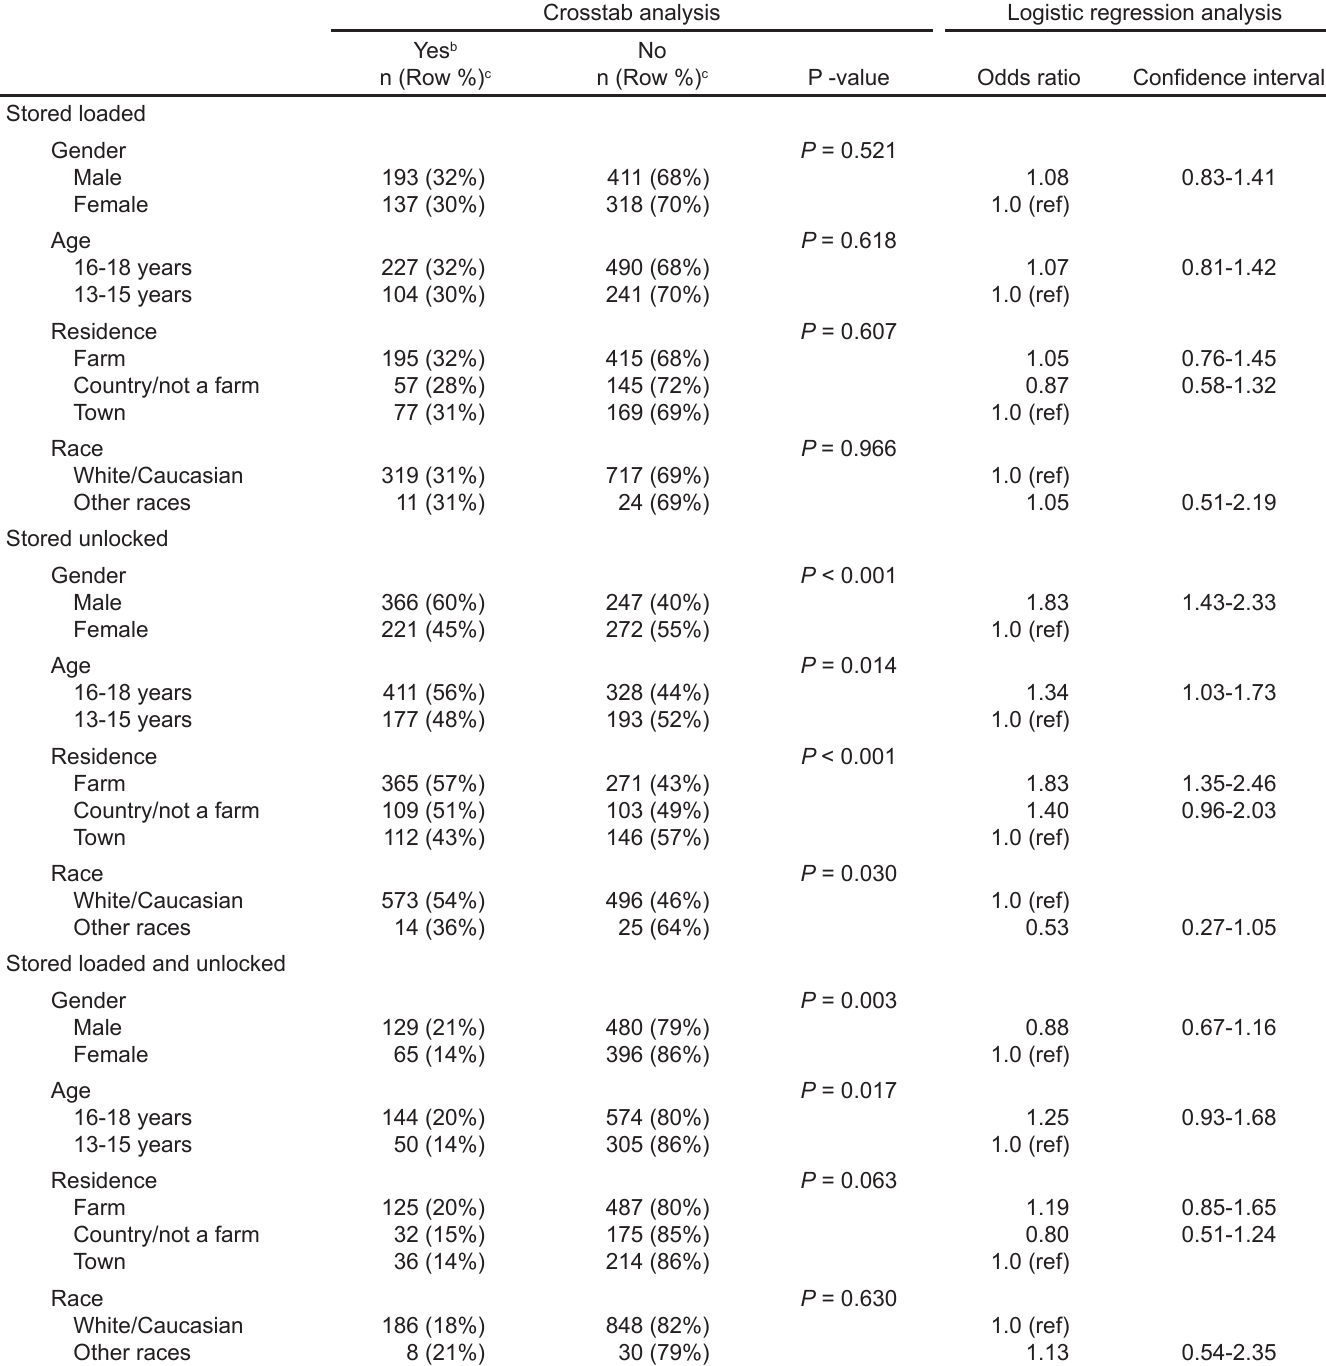
Table 5. Bivariate and multivariable logistic regression analyses regarding the storage of rifles/shotguns in the homes of adolescent survey respondents.